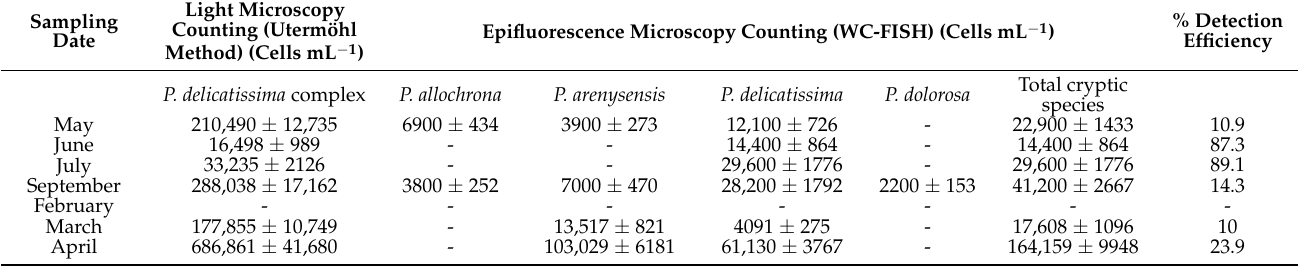
Table 6. Cell density (cell mL − 1 ) in natural samples before WC-FISH was estimated as a P. delicatissima complex and cell density of some Pseudo-nitzschia delicatissima cryptic species after WC-FISH. The detection efficiency (%) of the WC-FISH was calculated by the ratio between epifluorescence counting vs. light microscopy